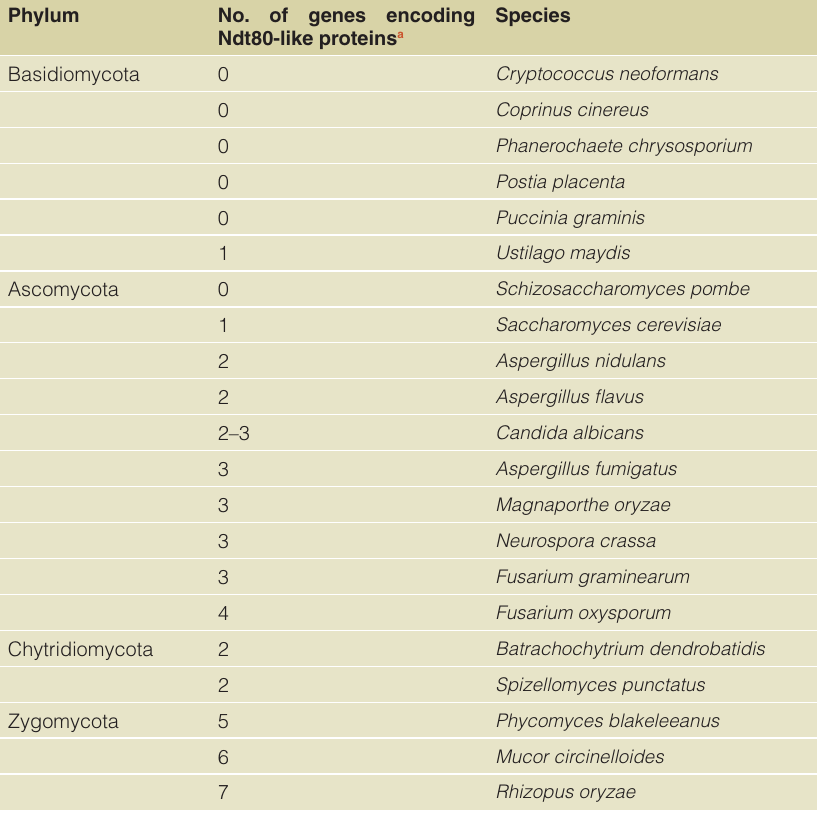
Table 5. The Ndt80 class of p53-like transcriptional activators in fungi.